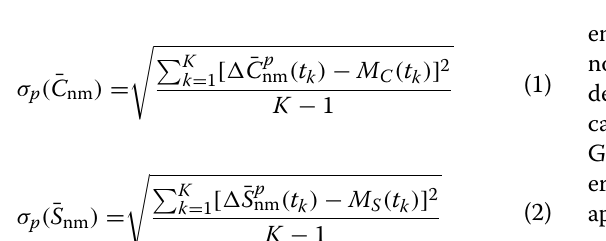
¯ C p ¯ S p nm and (cid:31) nm provided by